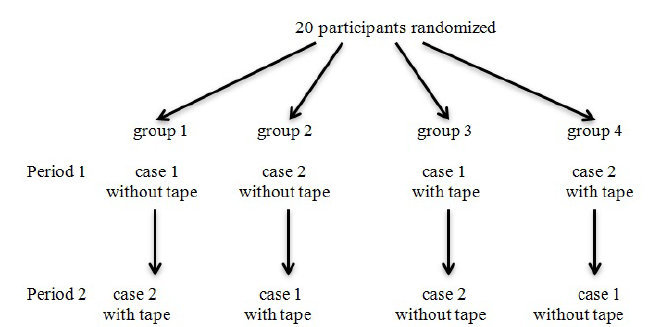
Figure. Design of the two-period, two-treatment crossover trial; “intervention” denoted use of the length-based